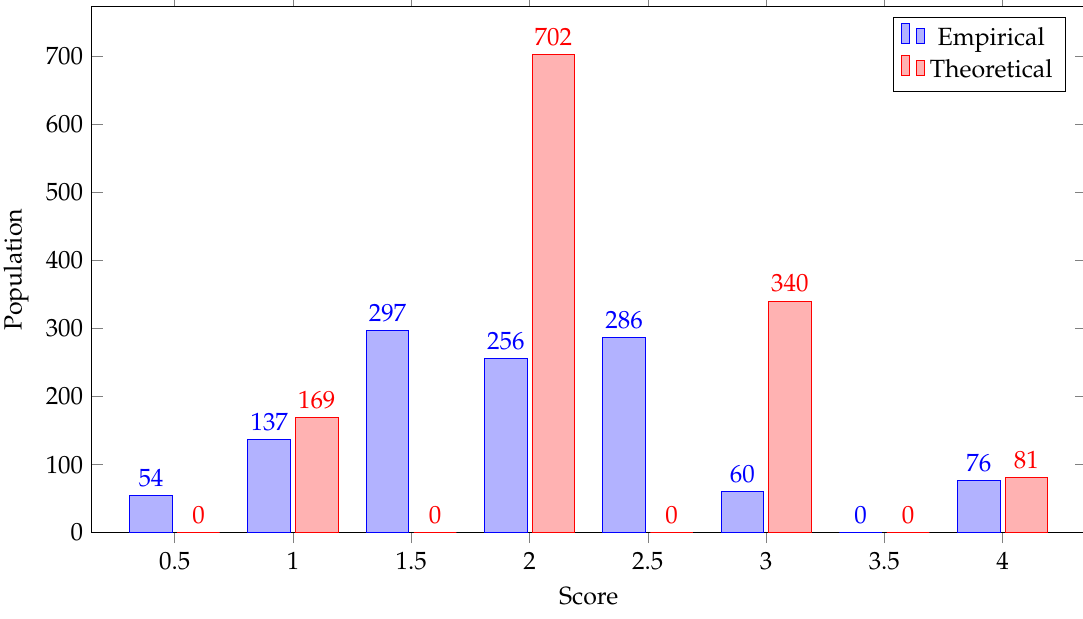
Figure 8. Comparison of populations per score for theoretical and empirical